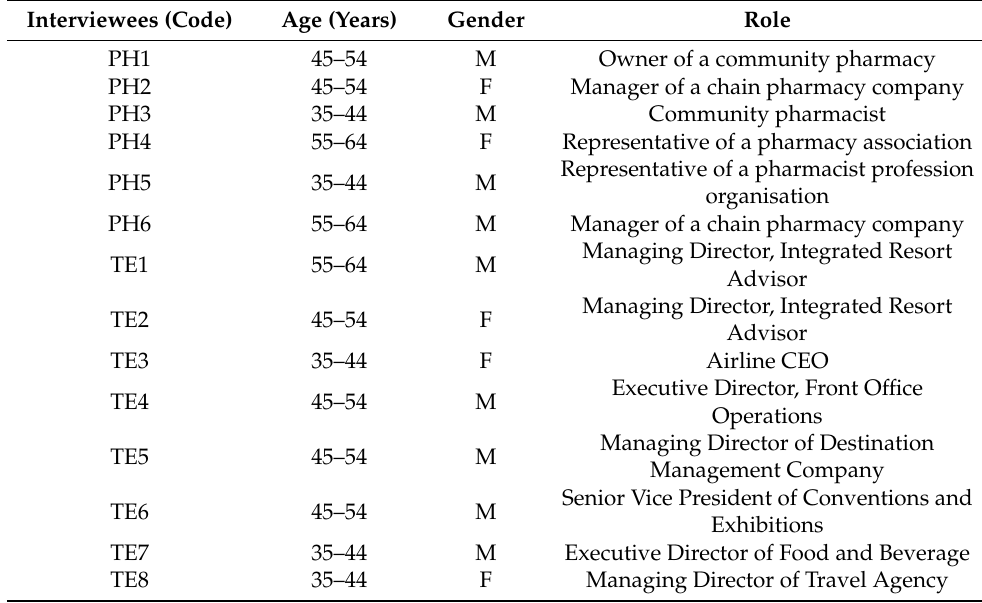
Table 2. Profile of pharmacists and tourism